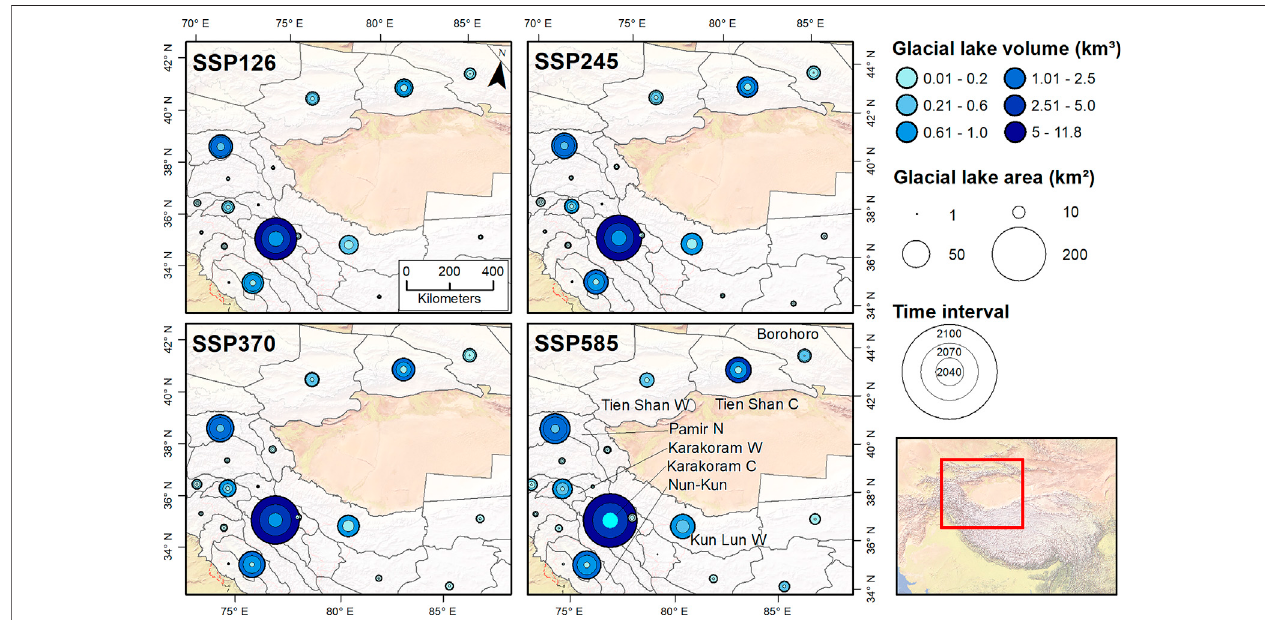
FIGURE 7 | Glacial lake formation under four SSP scenarios in northwestern HMA. The three timesteps (2040, 2070 and 2100) indicating the development throughout the 21st century are indicated by three overlying circles.